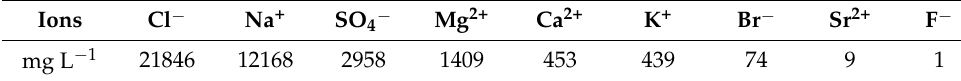
Table 3. The approximate chemical composition of seawater (main